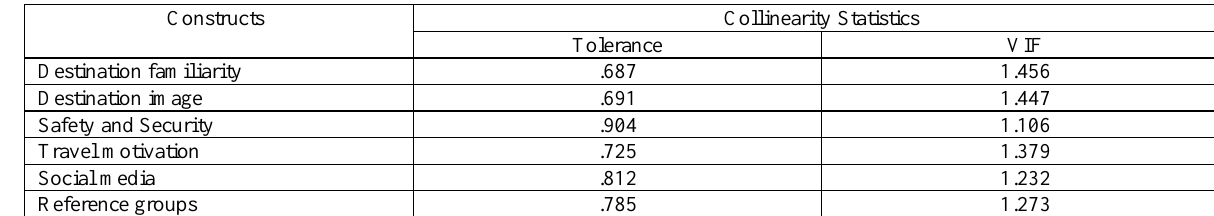
Table 3. Multicollinearity test